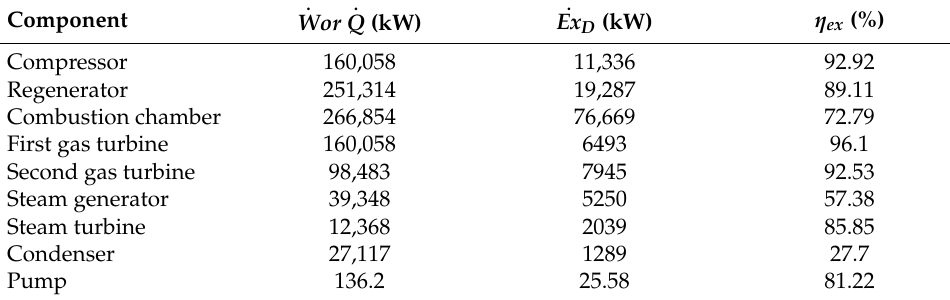
Table 11. Energy and exergy analysis of Config.